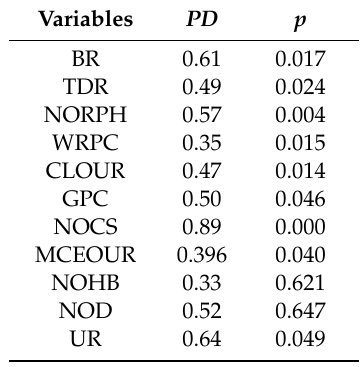
Table 4. The result of factor detector about social and environmental factors of